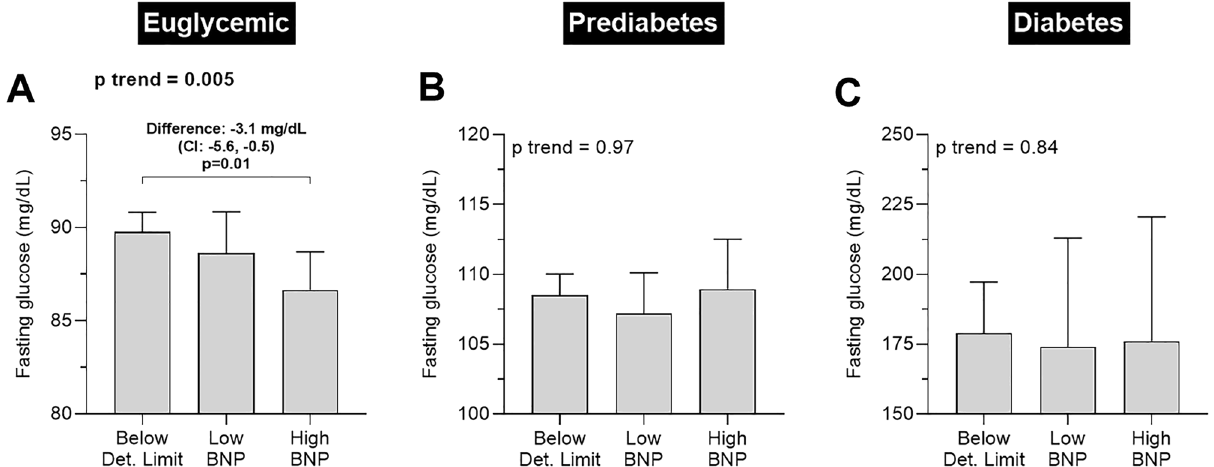
Figure 5. Subgroup analysis: associations between NT-proBNP concentration and fasting plasma glucose in ( A ) euglycemic, ( B ) prediabetic, and ( C ) diabetic individuals. Euglycemia was defined as fasting plasma glucose < 100 mg/dL, prediabetes was defined as fasting plasma glucose between 100 and 126 mg/dL, and diabetes was defined as fasting plasma glucose > 126 mg/dL. Bars denote mean and error bars denote 95% CI of the mean. P trend analyses were performed using a linear regression model with NT-proBNP group as ordinal covariate and the variable of interest as dependent variable. Statistical significance of between-group differences was calculated by unpaired t test. Definition of NT-proBNP groups is shown in Fig. 2. CI; confidence interval; NT-proBNP, N-terminal pro brain natriuretic